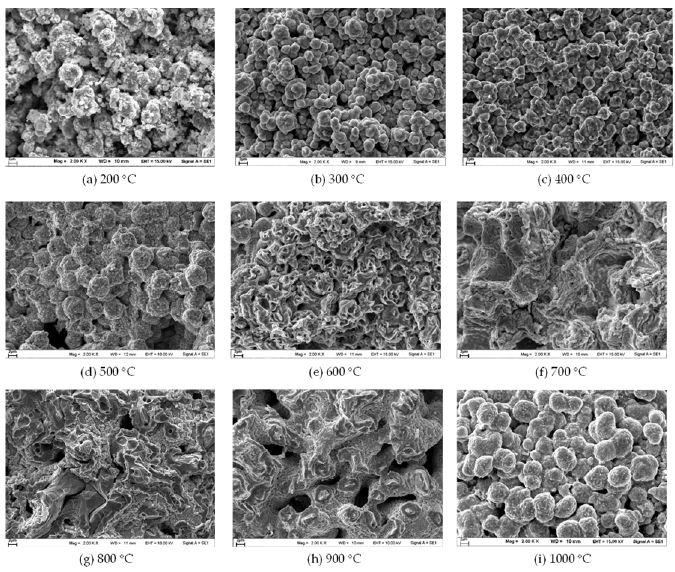
Figure 2. The SEM photographs of nano-copper clay fired at different temperatures: ( a ) 200 °C, ( b )